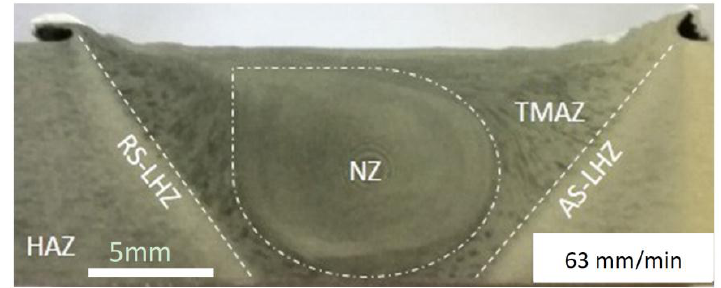
Figure 4. Macrograph of friction stir welded joint in 63 mm/min.